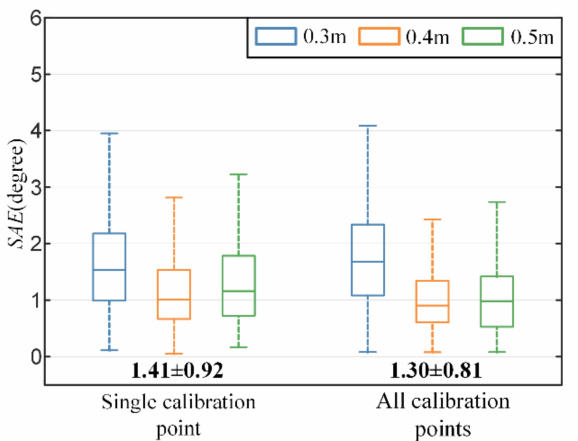
Figure 8. Comparison of primary calibration method and recalibration method with different number of calibration points. The bold numbers at the bottom are the angular error in degrees (mean ± standard